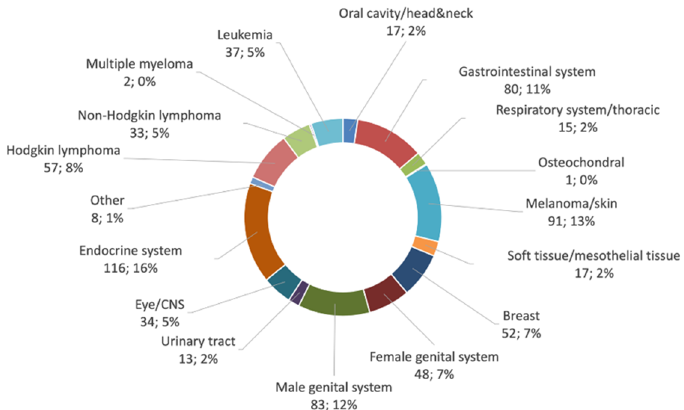
Figure 2. Diagnostic groups of solid and hematologic malignancies and their relative proportion of all invasive cancers that occurred in 704 15- to 39-year-old patients registered by the Augsburg Tumor Data Management of the Comprehensive Cancer Center Augsburg from 2014 to 2018 are shown in the ring diagram.